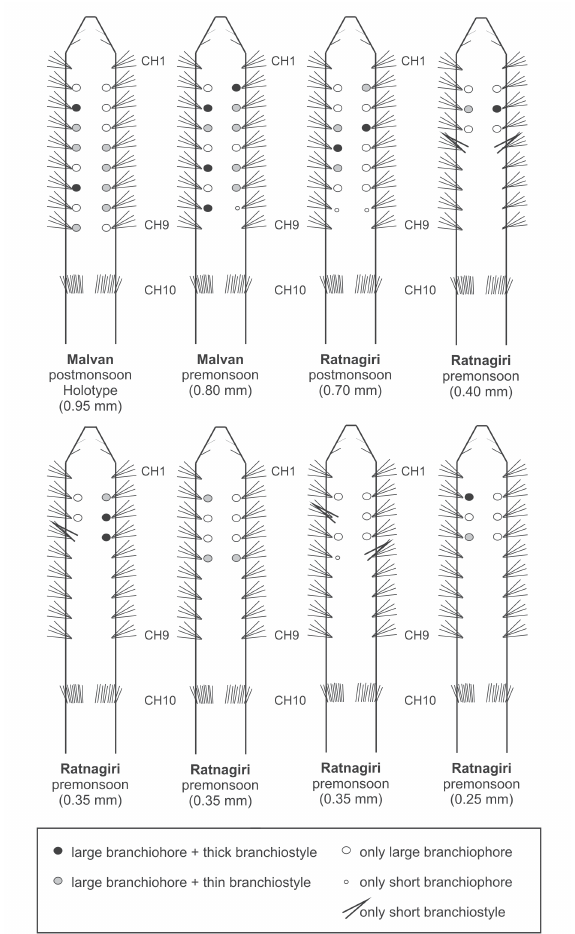
Fig. 9. Schematic drawings (not to scale) in dorsal view of some paratypes (MNCN and NIO) of Heterospio indica sp. nov., showing diversity of branchial arrangement in relation to size. Chaetigers numbered from CH1 (biramous) to CH10 (first flange-like). Width of anterior region